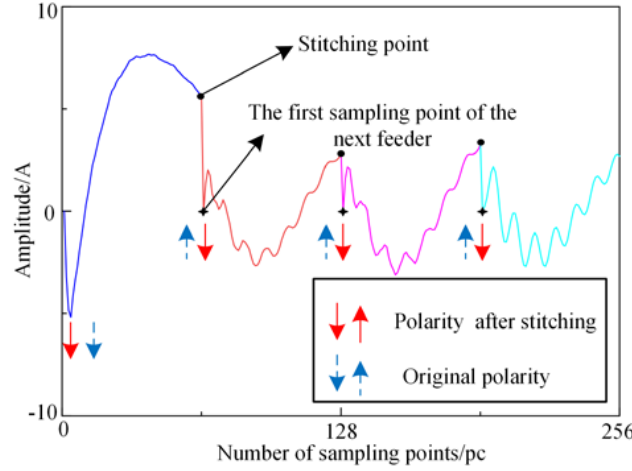
Figure 5. Schematic diagram of system fault data polarity analysis.